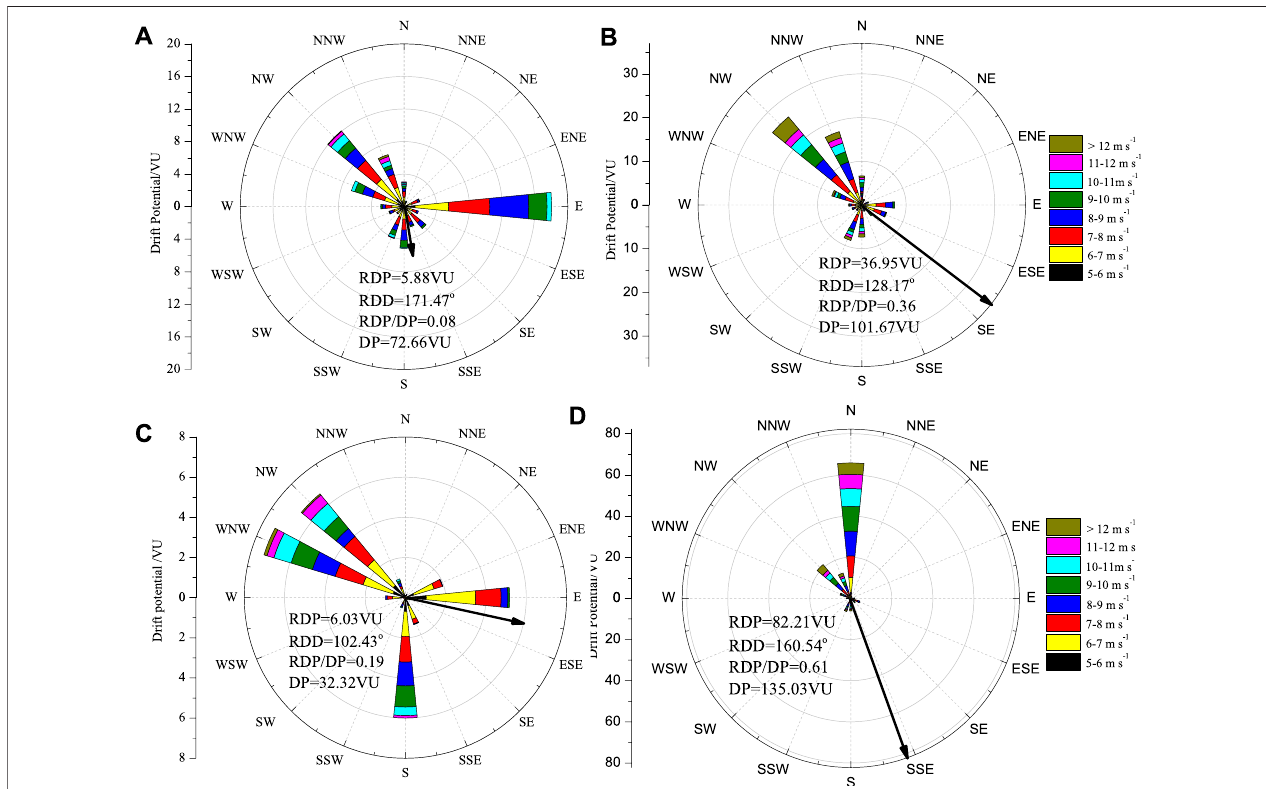
FIGURE 6 | Sand drift potential at No. 1 and No. 2 in 2018 and 2019. (A) No. 1 in 2018; (B) No. 1 in 2019; (C) No. 2 in 2018; and (D) No. 2 in 2019.